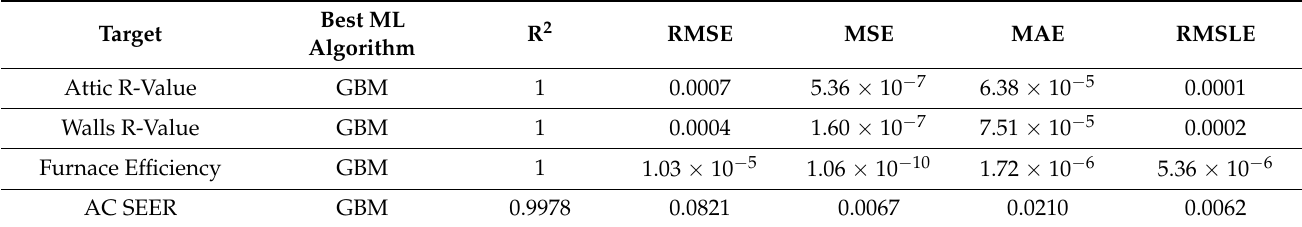
Table 9. Models’ prediction evaluation parameters for validation using thermostat-derived information.